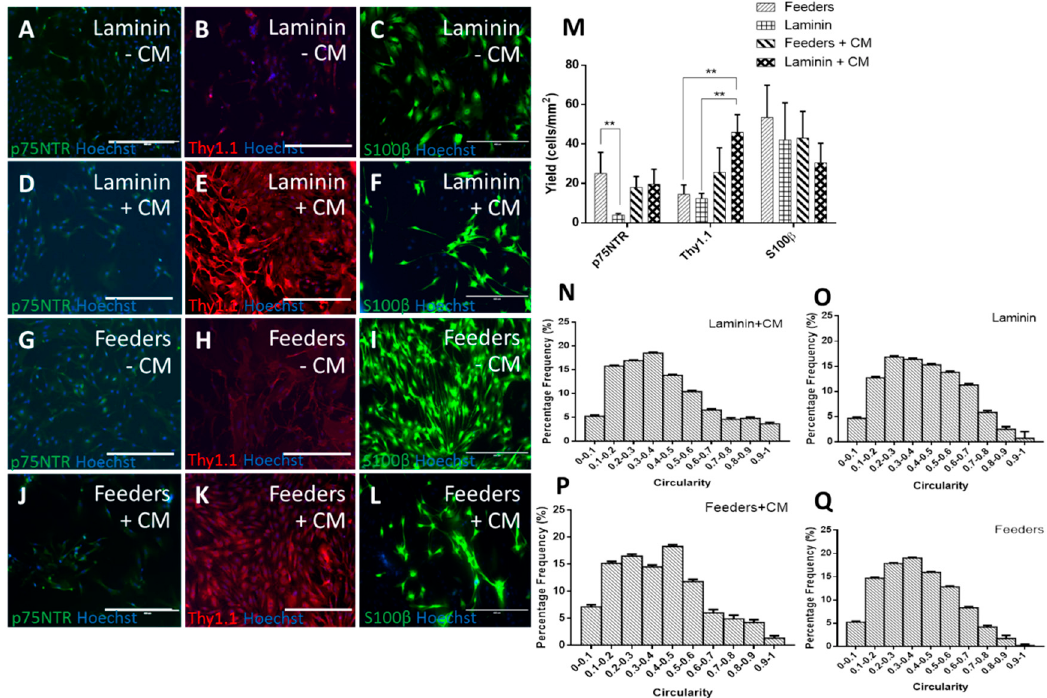
Figure 1. Fluorescent micrographs of primary rat olfactory mucosal cells (OMCs) cultured on laminin ( A–F ) and HuG418 feeders ( G–L ) in the presence ( D–F , J–L ) and absence ( A–C , G–I ) of HuG418 conditioned media and stained for olfactory ensheathing cell (OEC) biomarkers p75NTR and S100 β and fibroblast marker Thy1.1. Positive cells were counted in ImageJ and calculated as the number of positive cells over the image area ( M ). OMCs cultured on laminin with standard media had the lowest yield for p75NTR, and the addition of conditioned media caused an upregulation of undesirable marker Thy1.1. Circularity was used as a measurement of morphology, and positive S100 β cells were analysed for their circularity ( N–Q ). Cells on laminin with standard media and feeders with conditioned media gave more enlarged cell morphologies. The scale bars represent 400 µ m. Data are the means ± SEM., n = 3. CM, conditioned media.